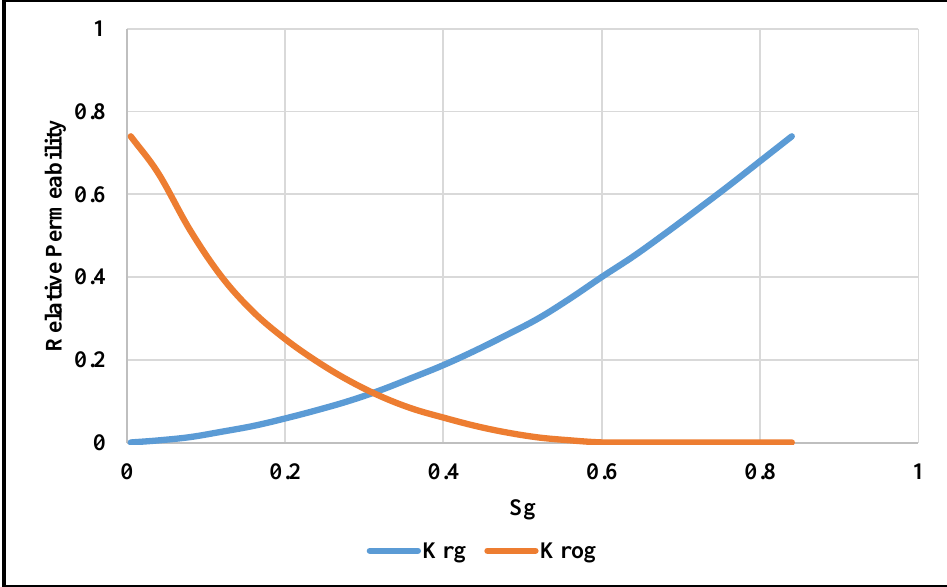
Figure 9. Water (K rw ) and oil (K row ) relative-permeability curves used in simulation model. Processes 2020 , 8 , x FOR PEER REVIEW